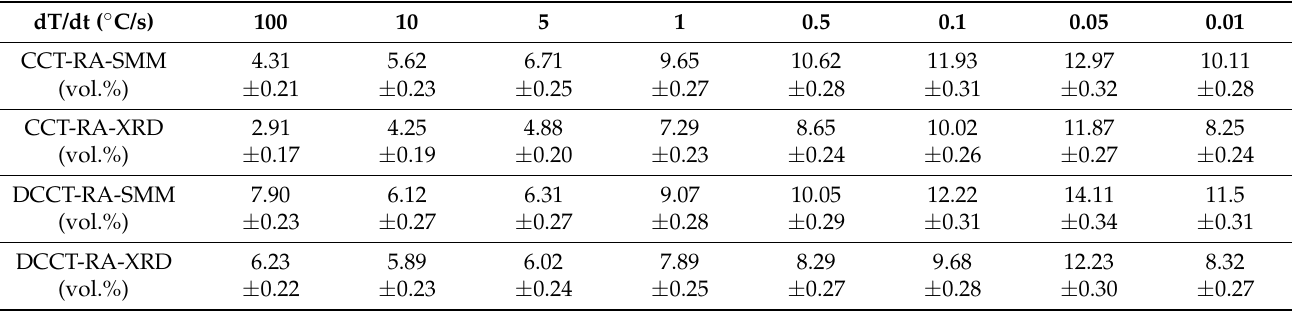
Table 5. Comparison of retained austenite content.